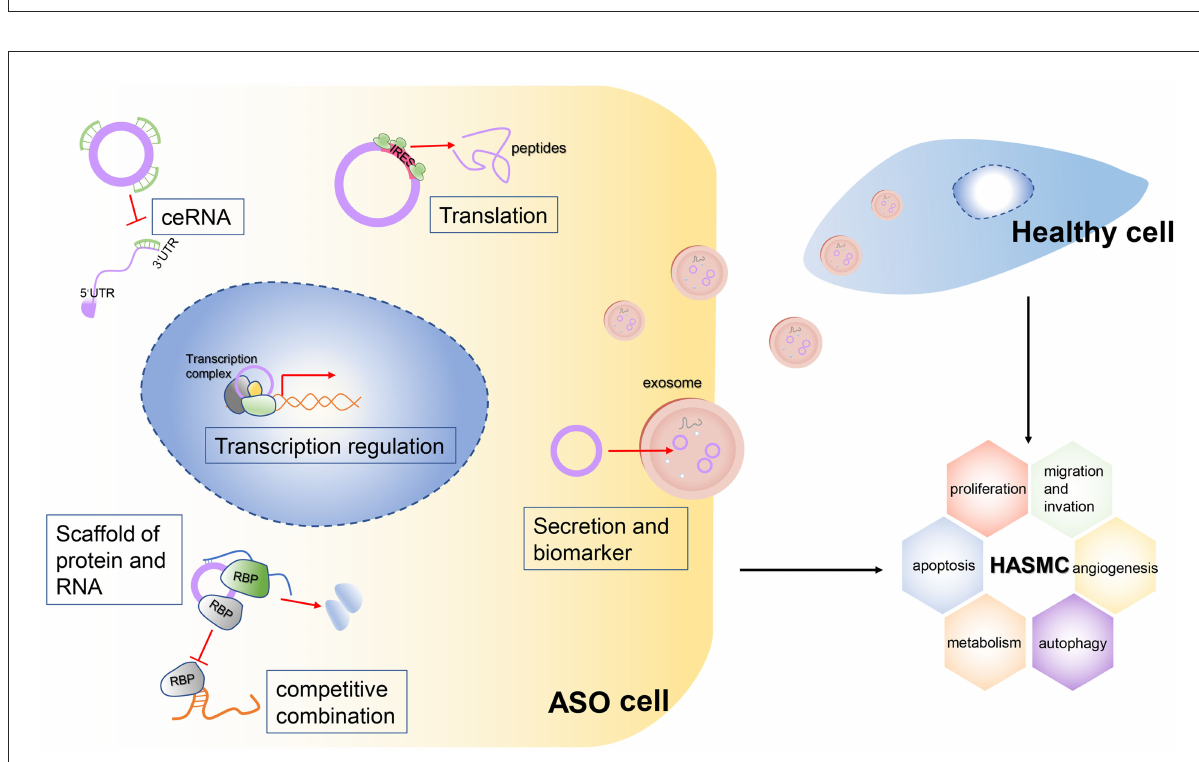
FIGURE6 Mechanisms of the potential roles of circRNAs in ASOs.The circRNA plays a vital role in the biological functions of cells. It can act as a sponge for multiple microRNAs, thereby blocking their binding to target RNAs. This mechanism is called the ceRNA mechanism. Second, some circRNAs, especially large circRNAs, competitively bind to certain RNA-binding proteins (RBPs), which inhibit the function of these RBPs. The circRNAs can bind not only to RBPs but also to multiple RNAs, so they can act as scaffolds to facilitate the binding and interaction of some RBPs with their targeted RNAs. Third, some circRNAs have internal ribosome entry sites (IRESs), so they can be translated into peptides and perform biological functions. Finally, circRNAs can be packaged into exosomes and be vehicled extracellularly into the bloodstream, so these circRNAs